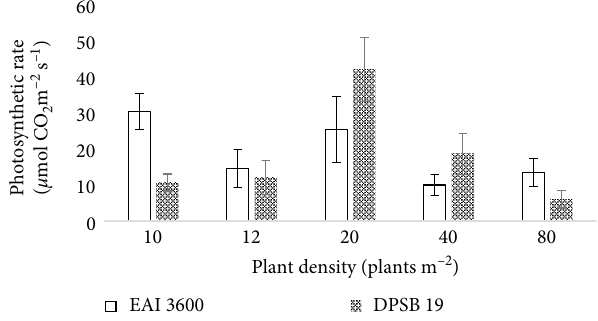
Figure 2: Effect of plant density and cultivar on photosynthetic rate at 50% flowering stage. Vertical bars represent ± standard error. Values significantly different at 푝 < 0.001